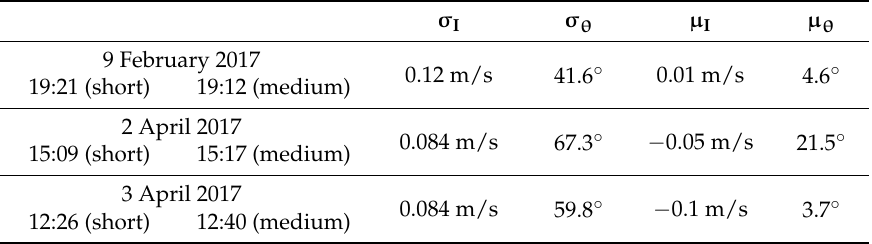
Table 3. Relative mean error and standard deviation of the intensity and direction of sea surface currents maps difference between short and medium pulse modes.